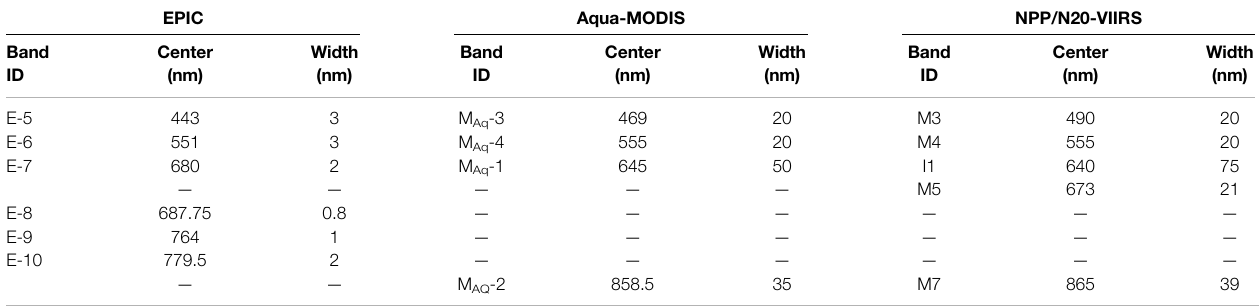
TABLE 1 | EPIC, MODIS, and VIIRS band nomenclature used for this study (ID), and wavelength center and width (FWHM) in nm obtained from https://avdc.gsfc.nasa.gov/ pub/DSCOVR/EPIC_NISTAR_Documents/DSCOVR-EPIC-Description.pdf, https://modis.gsfc.nasa.gov/sci_team/meetings/199310/presentations/x153_re fl _bands. pdf, and https://ladsweb.modaps.eosdis.nasa.gov/missions-and-measurements/viirs/. The bands are listed by increasing